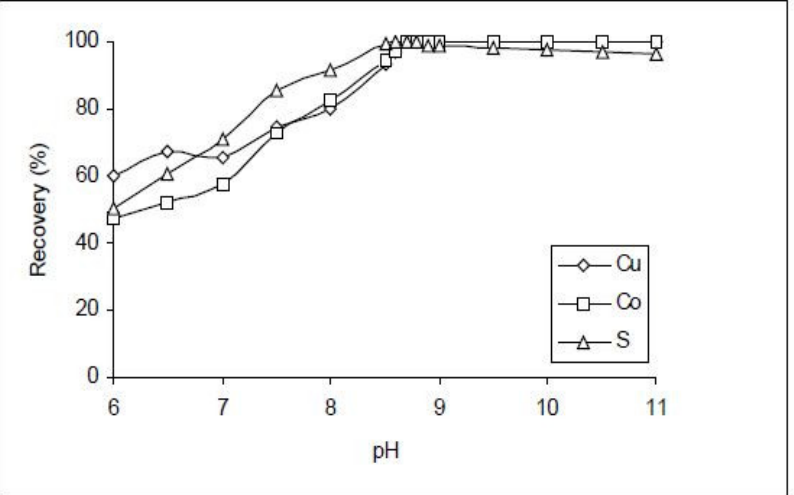
Figure 13. The flotation recovery of Cu, Co and S at different pH values (30.63 g H 2 S + 200.00 g H 2 O) [83]. H 2 O)